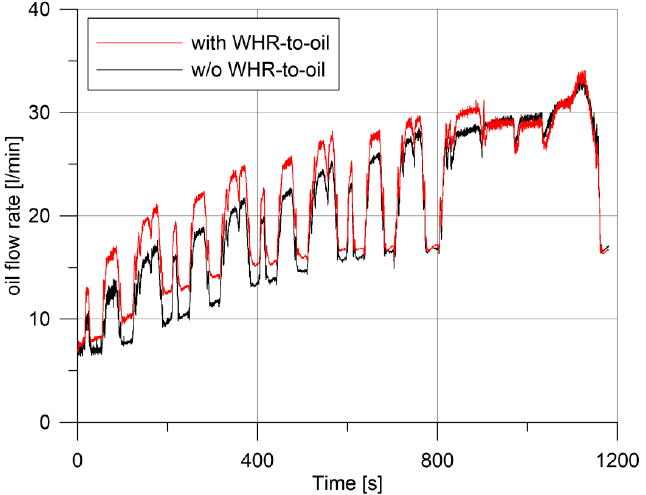
Figure 11. Oil flow rate in the lubricant circuit in the two test cases performed.